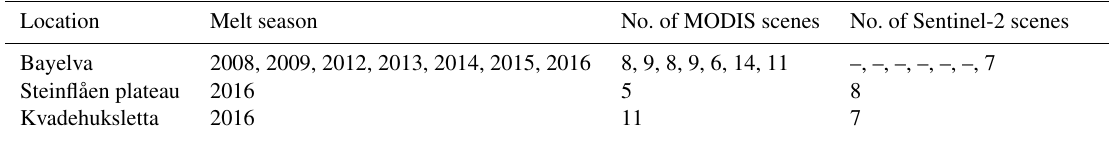
Table 3. Number of MODIS and Sentinel-2 scenes per melt season with field measurements available for the three study sites. Location Melt season